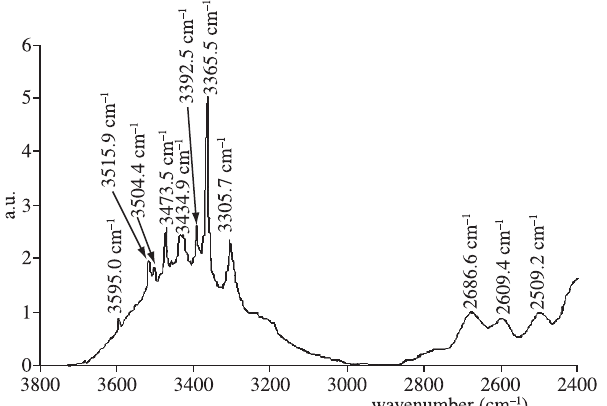
Figure 5. Infrared spectrum at 93 K of a sample of quartz from Marabá, Pará, Brazil that become smoky olive green after irradiation and olive green after